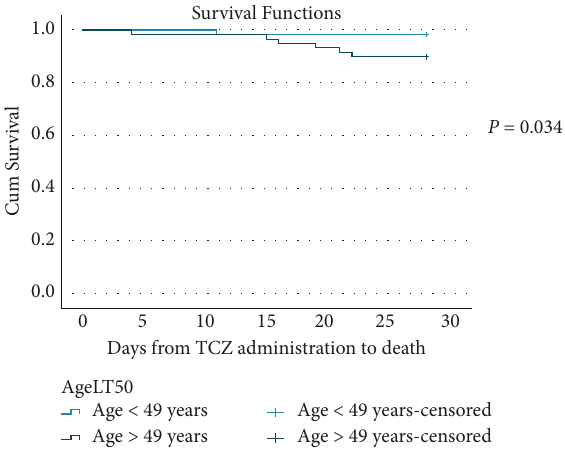
Figure 3: Kaplan–Meier curve for